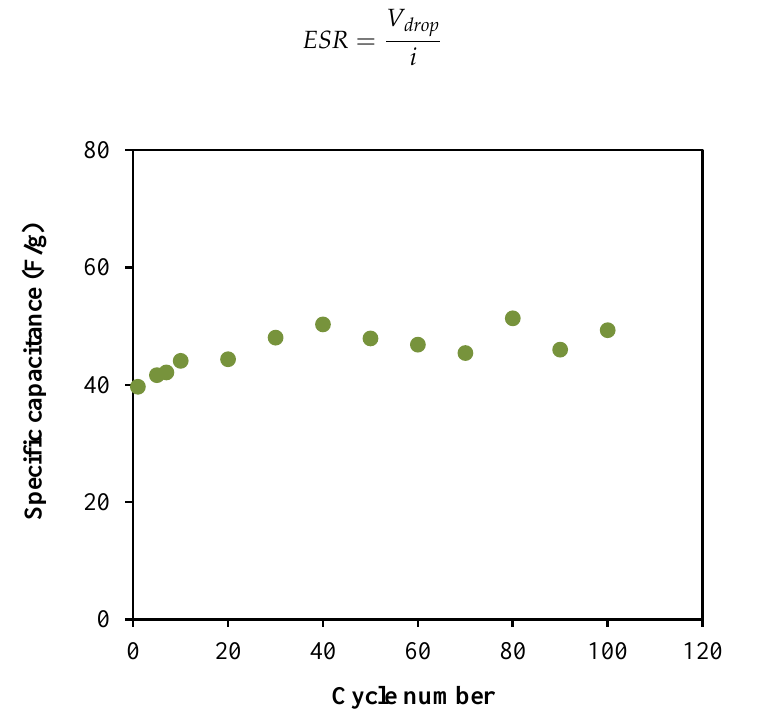
Figure 11. Specific capacitance, C s of the fabricated EDLC.